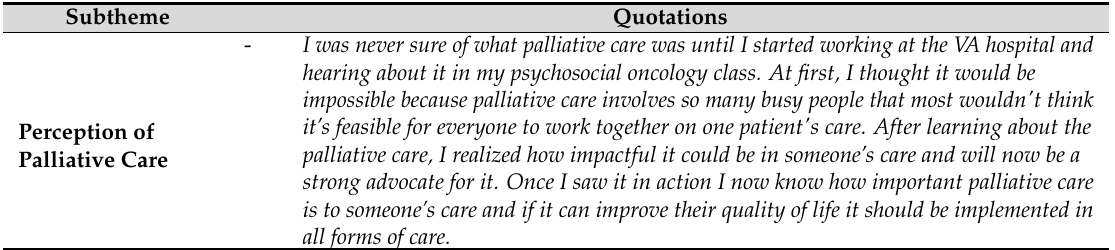
Table 4. Quotes related to the subtheme of perception of palliative